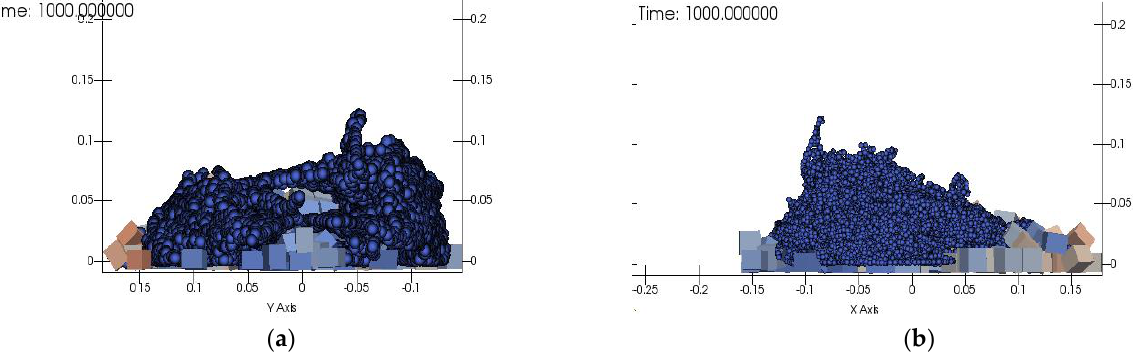
Figure 13. Simulation results of Group 2. ( a ) X-X cross-section view ( b ) Y-Y cross section view